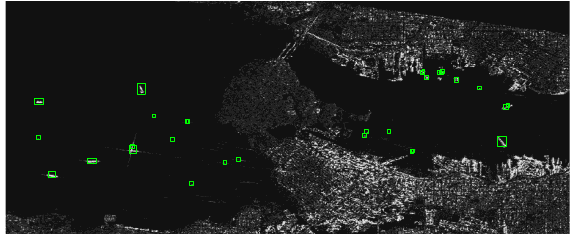
Figure 6. Detected ship targets in the 2D-PCA based fused result of the RadarSat-2 scenes, using a CFAR stencil of size